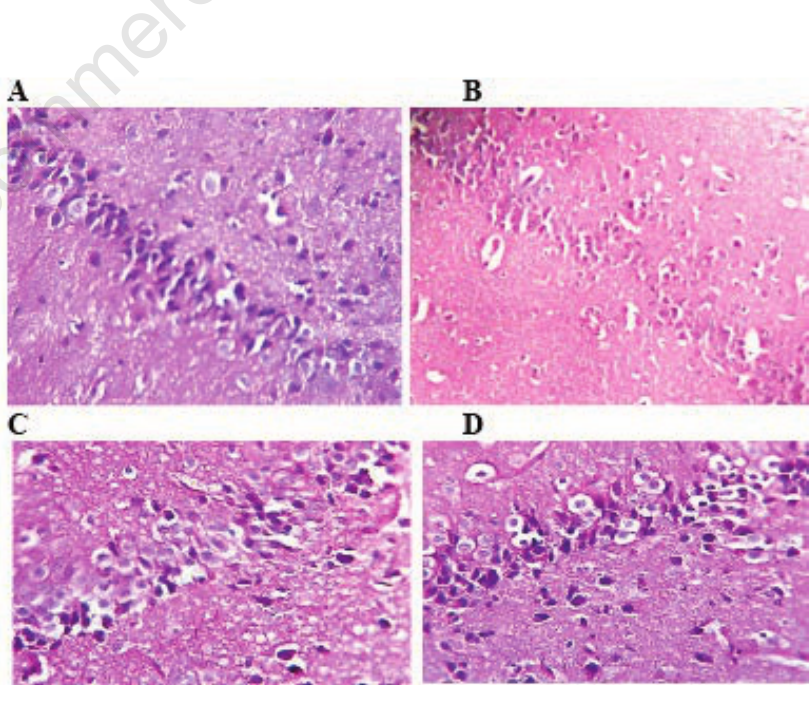
Figure 5. Histological architecture of the hippocampus in the control and TMX-treated groups (H&E: 400). In control group (A), normal histological architecture of hippocam- pus. Rats treated with TMX shows neurodegradation states of pyramidal neurons and granule cells and foam structure between neurons (B, C and D) (A, B, C and D H&E;